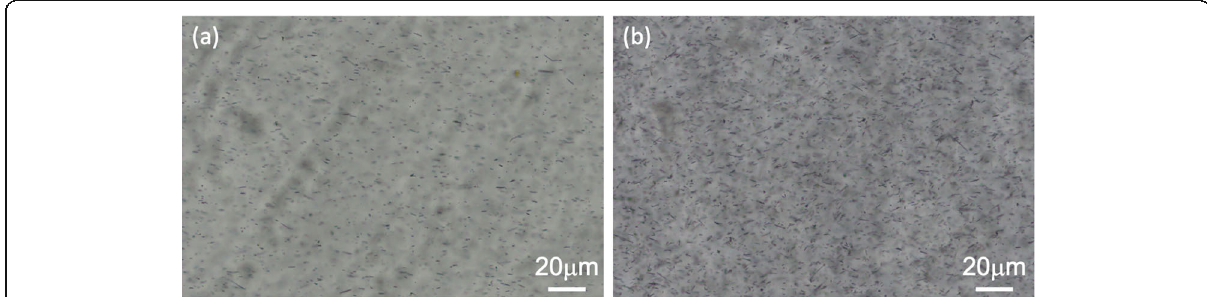
Fig. 2 Optical micrographs of UNST PLA-WS 2 nanocomposite films containing 0.1% (a) and 0.6% (b) of WS 2